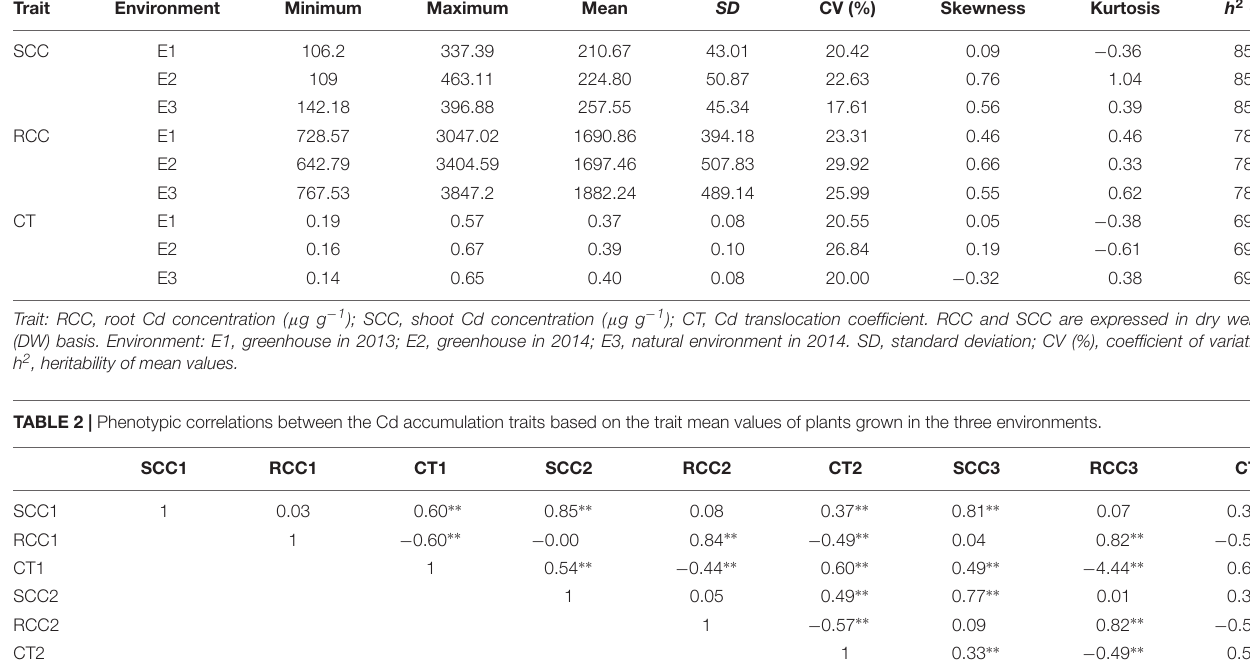
TABLE 1 | Phenotypic variation for Cd accumulation in 419 accessions of Brassica napus. Trait Environment